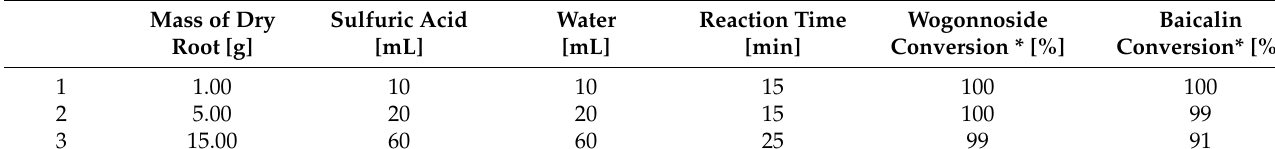
Figure 2. Hydrolysis of the major glucuronides from the root of the Scuttelaria baicalensis L. Table 1. Conditions of the hydrolysis reaction of the dry root of Scutellaria baicalensis L.